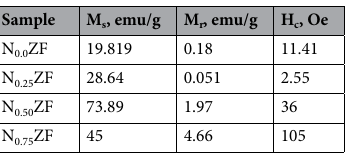
Table 7. Magnetic parameters of NZF samples with different ratios of Ni.